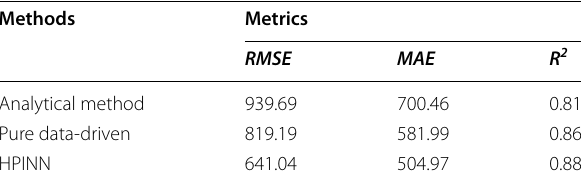
Table 5 Performance comparison of digging forces on real- world measurement